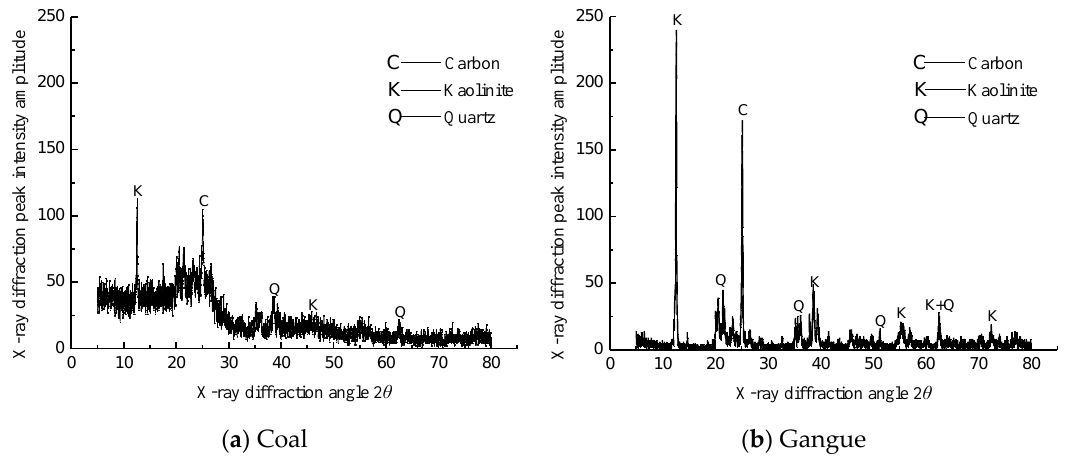
Figure 8. X-ray diffraction test results of coal and gangue samples.